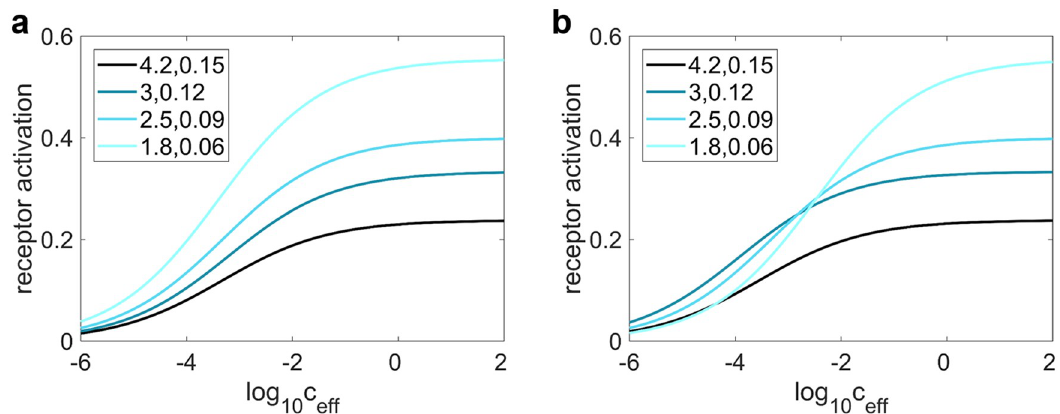
Fig 3. Receptor activation r � for receptors with different K eff and K 0 , where the correlation between the parameters are (a) 2 , the fraction of activated receptors for strongly positive and (b) non-positive. When K eff is strongly positively correlated with K 0 2 different receptor types is roughly constant over a large range of effective concentrations, which indicates a high linear correlation between the activation patterns at different c eff . The opposite is observed if they are not positively correlated. Legend format: first number 1 , second number 1 K 0 2 K eff